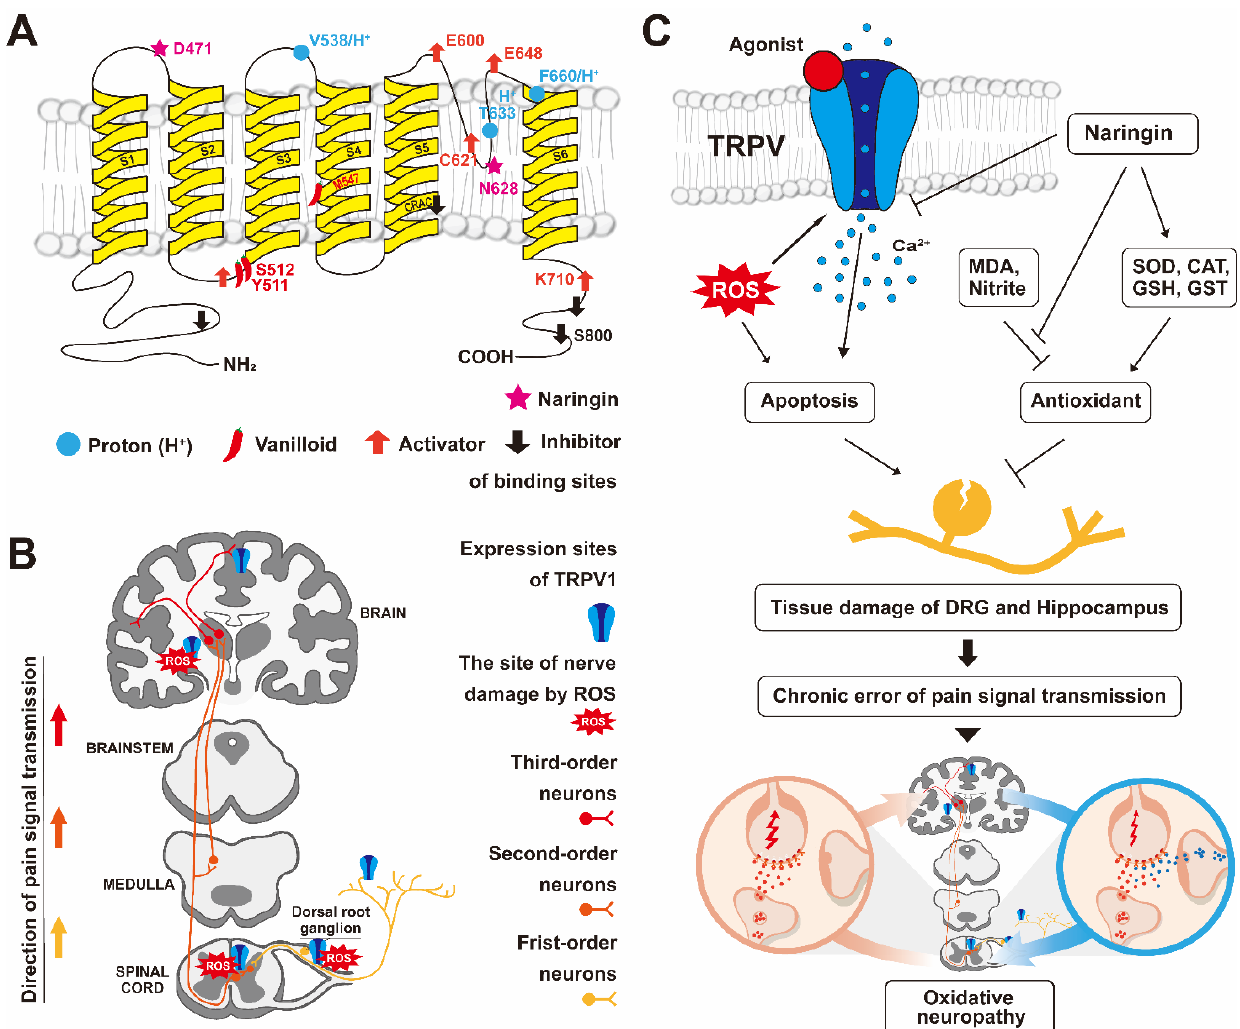
Figure 1. Schematic diagram of the various interaction sites of TRPV1 and the mechanism underlying the neuroprotective effect of naringin in the pain pathway: ( A ) one subunit of TRPV1 has six transmembrane domains (yellow) and a pore loop (S5–S6). TRPV1 can function only when these four subunits form a tetramer. The light blue circle is the location where the proton binds to TRPV1. The pepper-shaped symbol is the site where vanilloids such as capsaicin bind. The star shape is the binding site of naringin found in our present study. ( B ) The pain transmission pathway. The signal transduction process of pain involves three stages. Electrical signals are transmitted from the first-order neurons (yellow neurons) to the third-order neurons (red neurons), and finally, the brain perceives the pain. The blue receptor symbol is TRPV1 and marks the tissue location where it is expressed. ( C ) Naringin has a cytoprotective effect mediated through inhibition of neuronal hyperexcitation and oxidative stress via TRPV. The death of neuronal cells remains a permanent error in the signaling system, resulting in neuropathic pain. GSH is glutathione, MDA is malondialdehyde, SOD is superoxide dismutase, CAT is catalase, and GST is glutathione-S-transferase. Thirty members of the transient receptor potential (TRP) superfamily of proteins act as sensors for heat, cold, osmosis, volume, stretch, tremor, and taste [13,14]. Among them, transient receptor potential vanilloid member 1 (TRPV1) is a nonselective cation channel